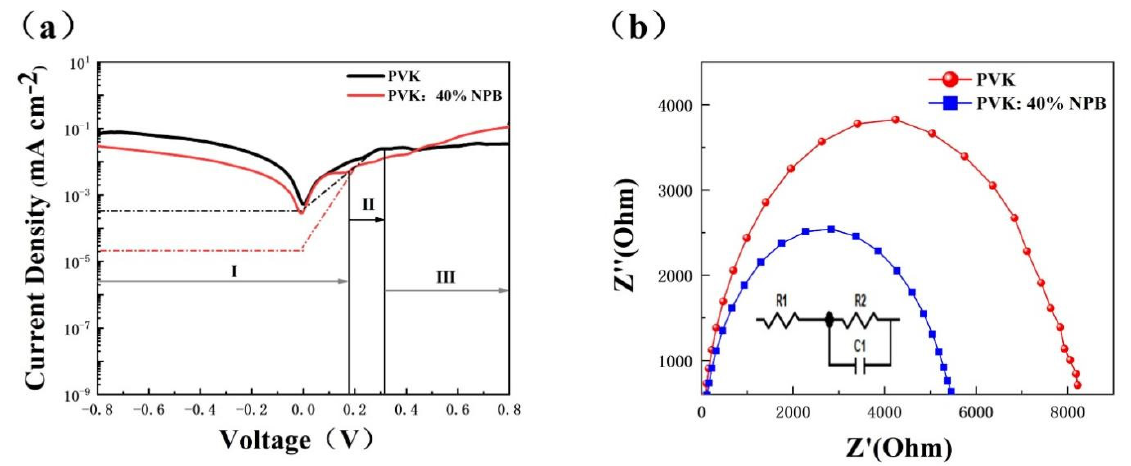
Figure 5. ( a ) Dark J − V curves and ( b ) Nyquist plot of PSCs.